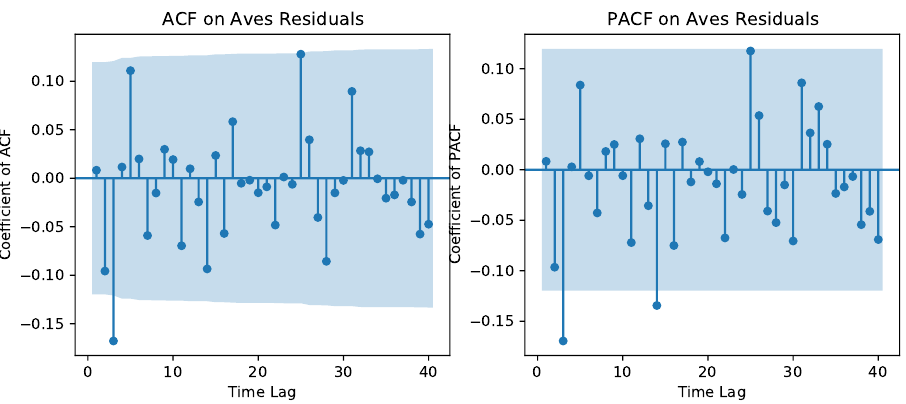
Figure 7. ACF and PACF on Aves residuals are white noise with 95% of the forecast errors below the error criteria. The Aves residuals from SARIMAX-only are the inputs of the LSTM-only.